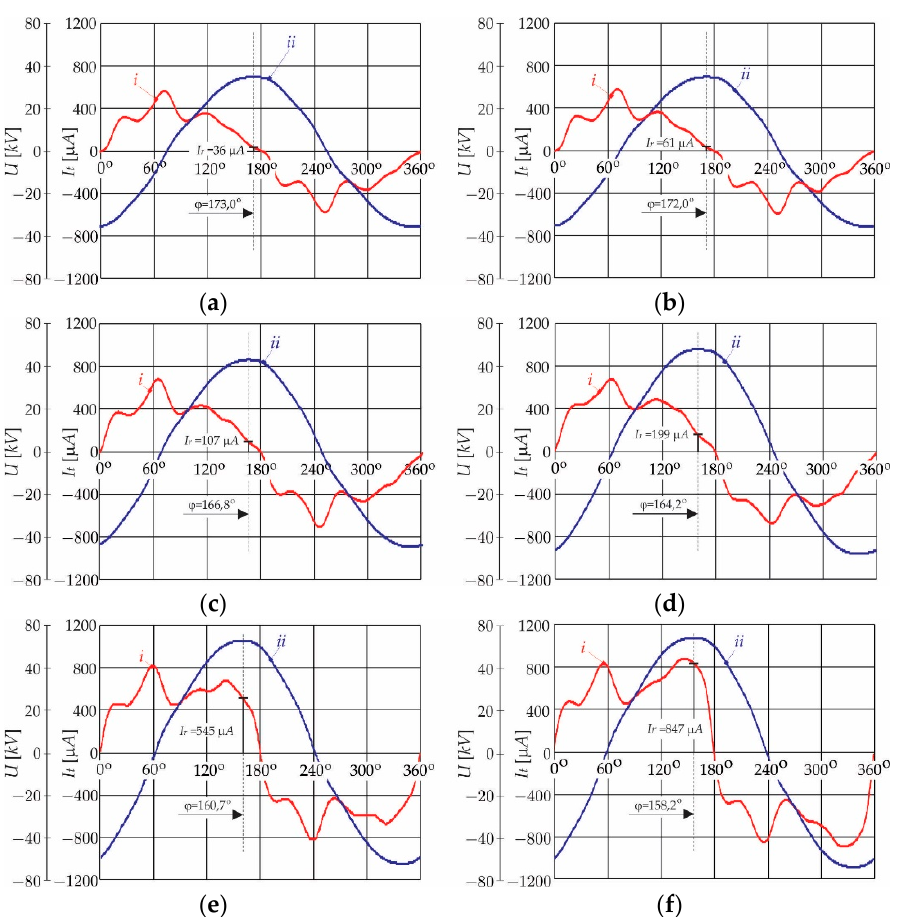
Figure 2. Measurement set-up scheme.